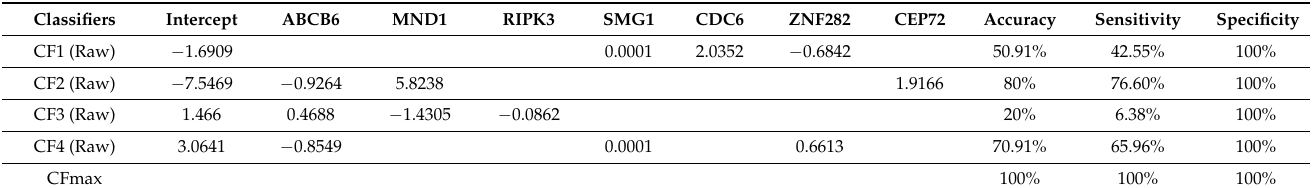
Table 3. Performance of individual classifiers and combined max-competing classifiers using blood- sample data GSE201530 to classify COVID-19-infected and healthy controls into their respective groups. The meaning of CF-i is the same as those in Table 1. Raw stands for raw counts.